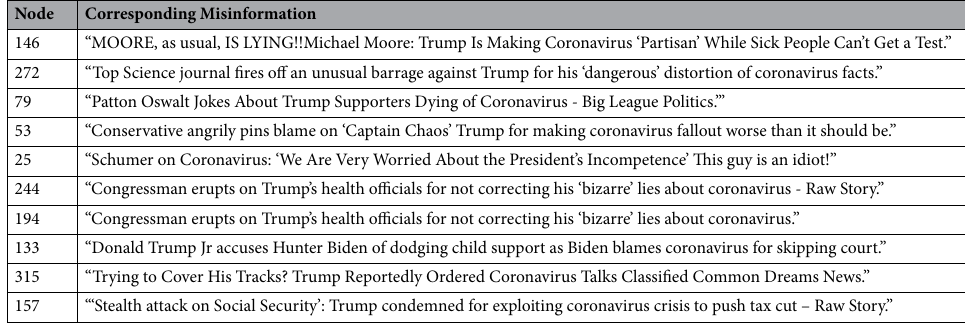
Table 1. Top 10 most connected nodes (and their corresponding tweets) in the example network shown in Fig.